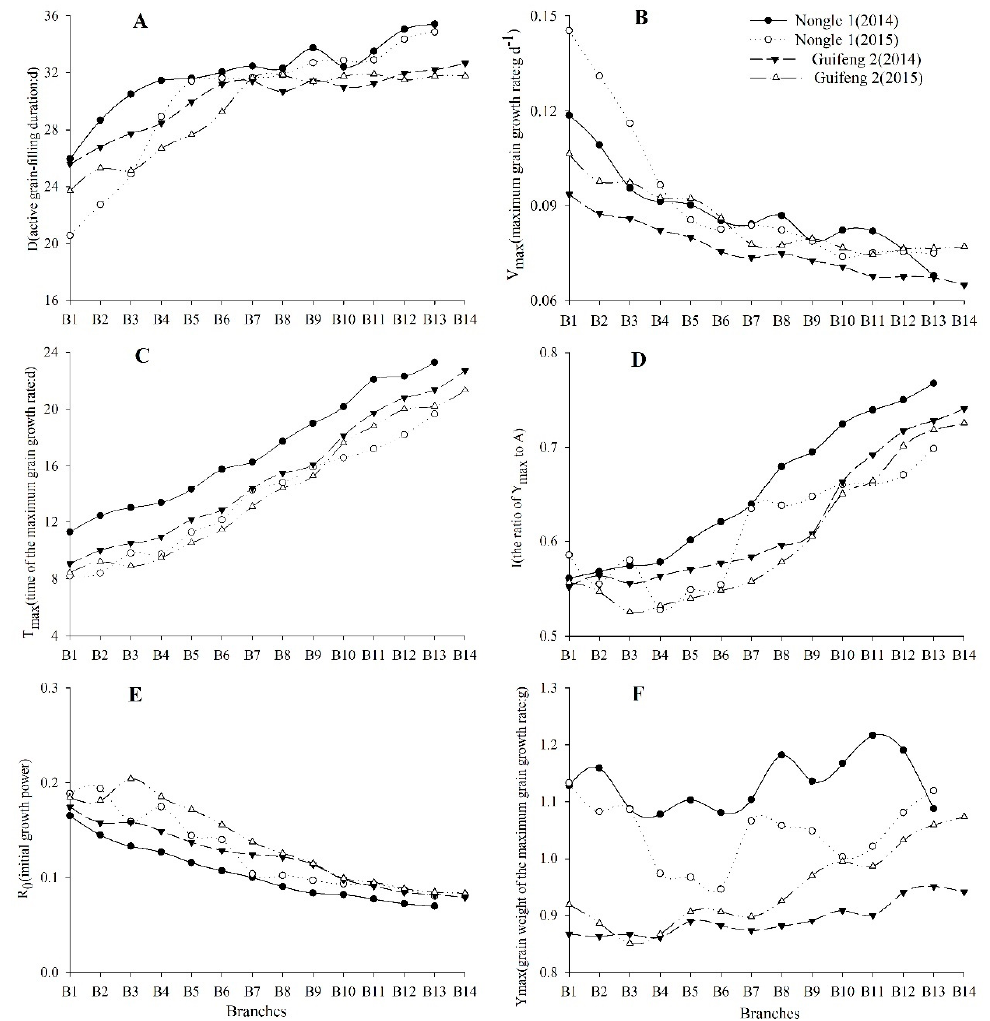
Figure 4. Variation of grain growth parameters of primary-branch grains at di ff erent positions for Nongle 1 and Guifeng 2 in 2014 and 2015. ( A ) active grain-filling period, ( B ) maximal grain growth rate, ( C ) time of the maximum grain growth rate, ( D ) the ratio of Y max to A , ( E ) initial growth